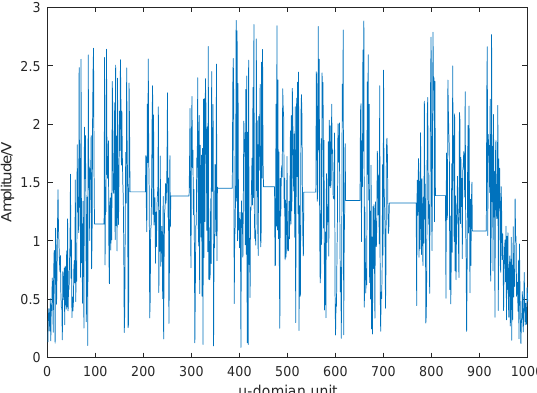
Figure 13. u -domain waveform of the compensated signal.